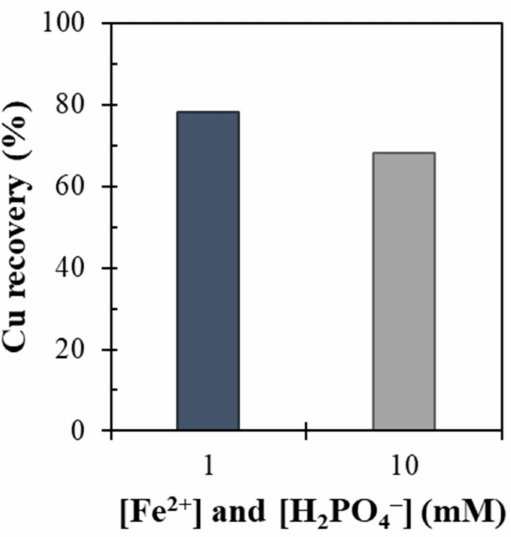
Figure 2. Effect of the concentration of Fe 2 + and H 2 PO −